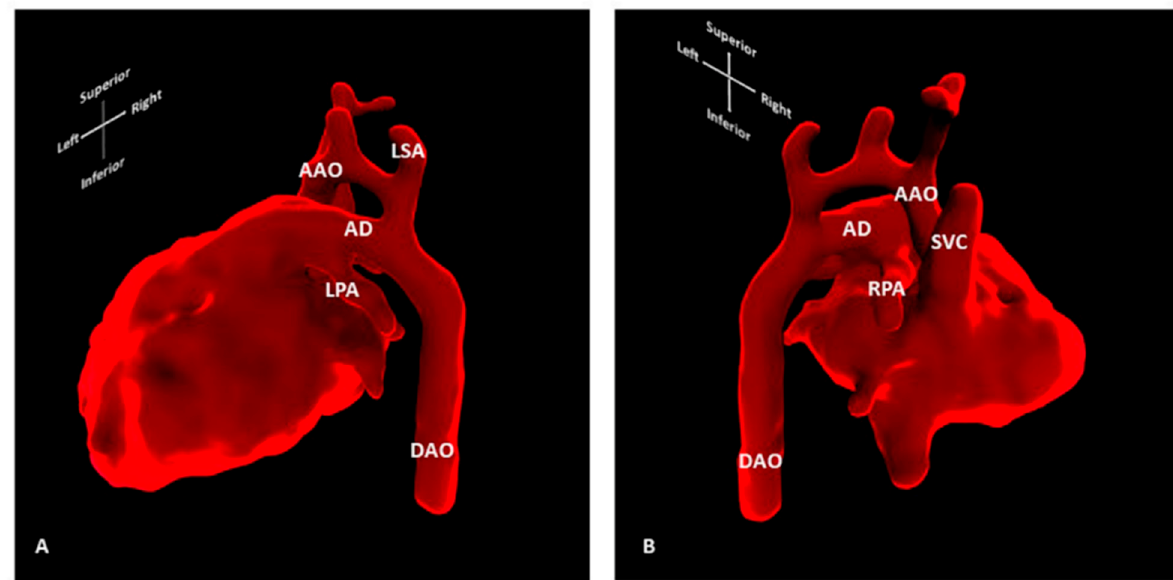
Figure 11. Three-dimensional foetal cardiac MRI showing high suspicion of CoA. Segmentation of motion-corrected 3D foetal cardiac MRI data, showing ( A ) left lateral and ( B ) right lateral view of the foetal heart. Foetal cardiac MRI was conducted at 30 + 2 weeks’ gestation for suspected coarctation of the aorta. Neonatal coarctation requiring surgical repair was confirmed after birth. AAO: Ascending aorta; AD: Arterial duct; DAO: Descending aorta; LPA: Left pulmonary artery; LSA: Left subclavian artery; RPA: Right pulmonary artery; SVC: Superior vena cava.